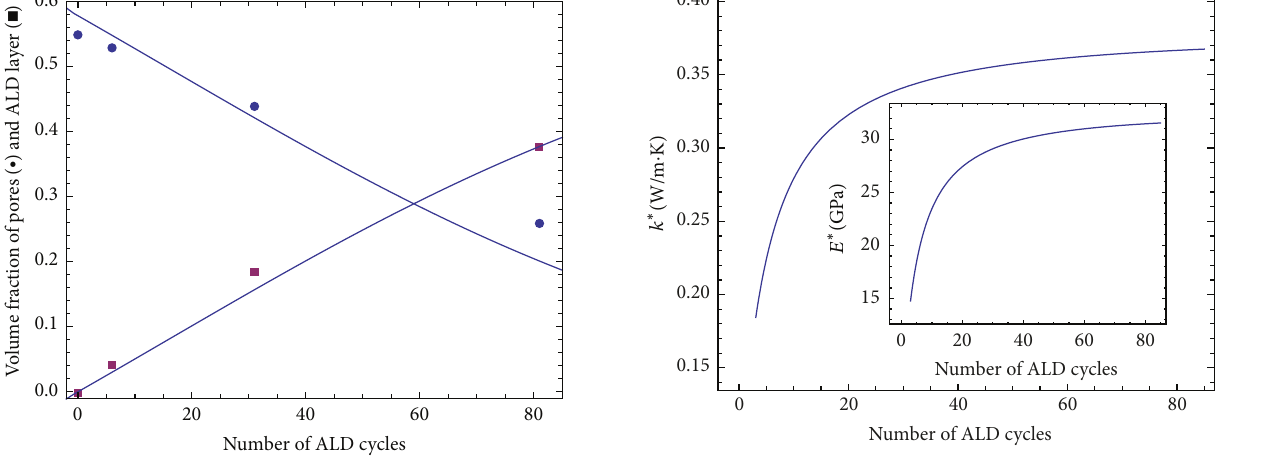
Figure 15: Effective thermal conductivity and Young’s modulus of Al 2 O 3 coated polypropylene versus ALD cycle